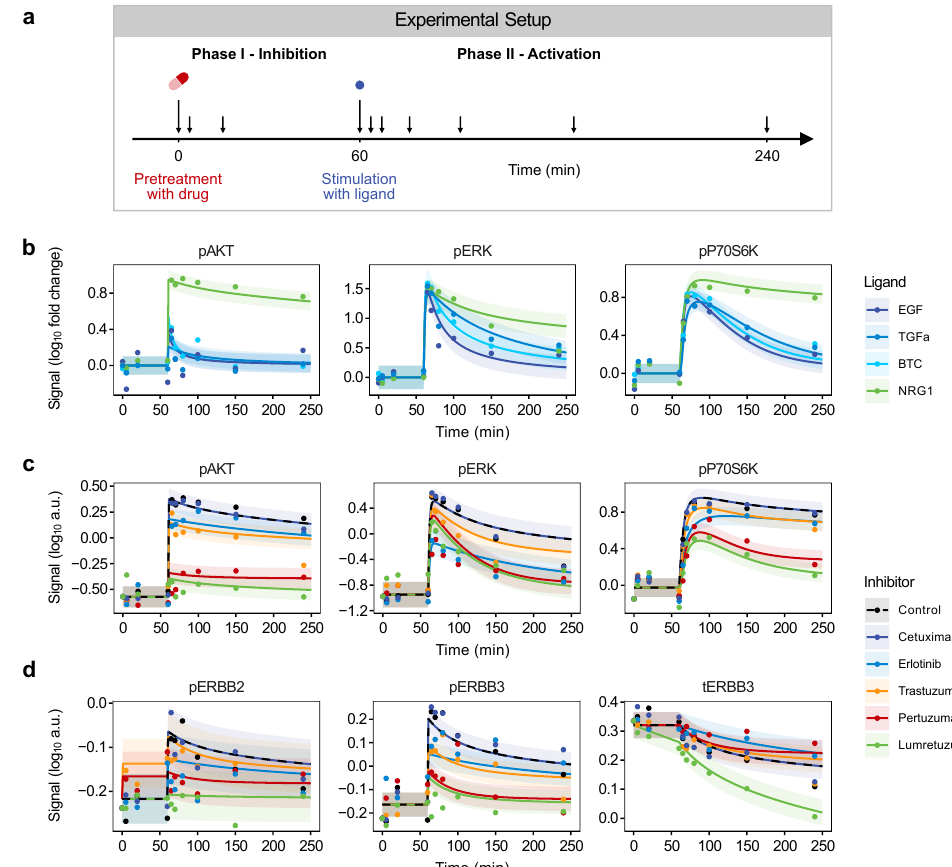
Figure 3. Model calibration on time-resolved quantitative reverse phase protein array (RPPA) data. ( a ) RPPA data generation. Cells were pretreated with drugs for 60 min (phase I) and then stimulated with ligands for up to another 180 min (phase II). Samples were taken at ten time points between 0 and 240 min, as indicated by arrows. ( b – d ) RPPA measurements and model fits of MCF7 cells. ( b ) The cellular response to the four ligands is depicted for the three major downstream proteins pAKT, pERK and pP70S6K. ( c ) The impact of the five drugs under NRG1 stimulation is shown for the same downstream proteins ( d ) as well as for pERBB2, pERBB3 and total ERBB3 (tERBB3). All data represents the mean of biological replicates (n = 3) and is displayed as dots. Trajectories of the model fit are indicated as solid or dashed lines along with shaded error bands corresponding to one standard deviation. In total, the data of eight proteins and four ligands in MCF7 as well as T47D cells were used for the initial model calibration. Corresponding data and model trajectories for T47D are depicted in Figure